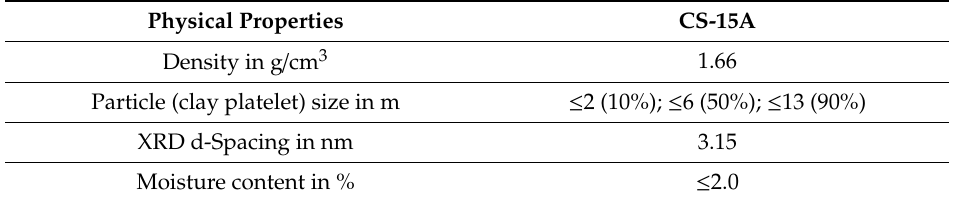
Table 2. CS-15A physical